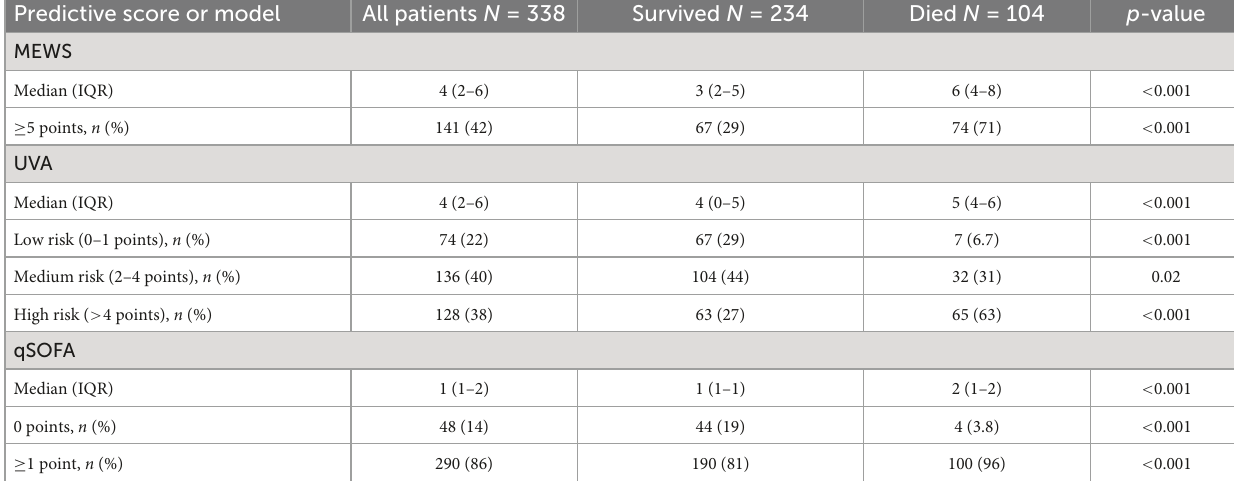
TABLE 2 Distribution of mortality scores and association with hospital